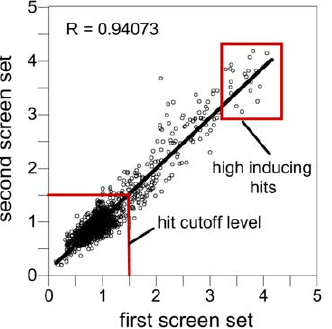
Figure 4. Screen results are reproducible. The GFP intensities of replica plate sets of screen 1 and screen 2 were plotted against each other. The linear regression between both plate sets demonstrates reproducibility of hit compounds. The cut off level for hit selection is